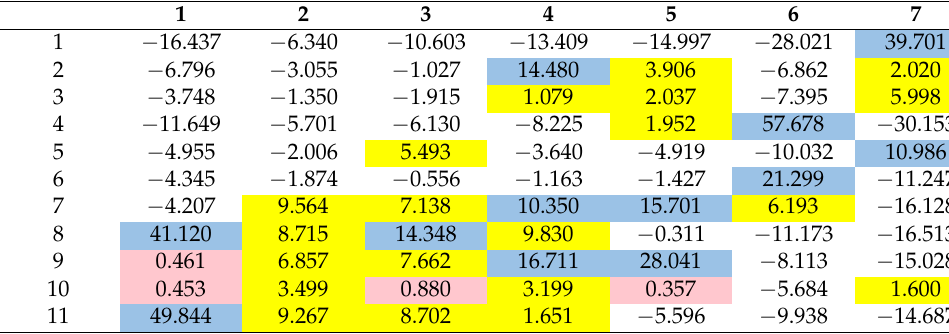
Table A10. Theoretical frequencies AFWW 2012 (C1/Class2133322).